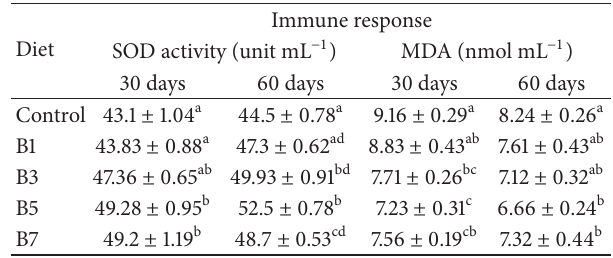
Table 4: Lysozyme (LA) and alternative complement pathway (ACP) activities observed on different sampling days after feeding Labeo rohita with banana peel flour (BPF) supplemented diets.